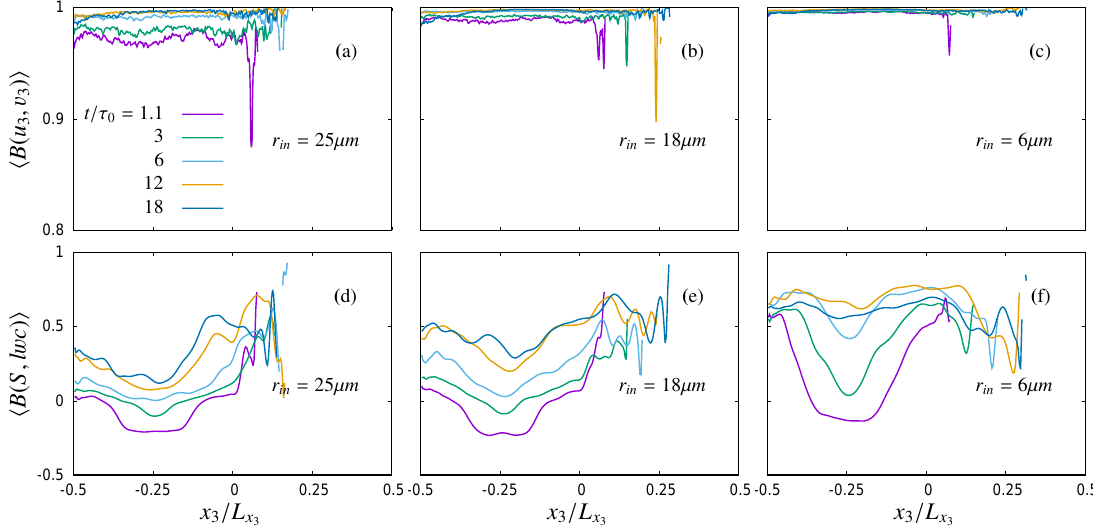
Figure 9. Correlation between fluid and droplet: ( a – c ) correlation between vertical component of fluid velocity fluctuations u (cid:48) and droplet velocity fluctuations v (cid:48) ; and ( d – f ) between supersaturation 3 3 fluctuations S (cid:48) and fluctuations in liquid water content lwc (cid:48) . Vertical panels from the left to right present correlation diagrams for 25 µ m, 18 µ m and 6 µ m initial droplet size populations